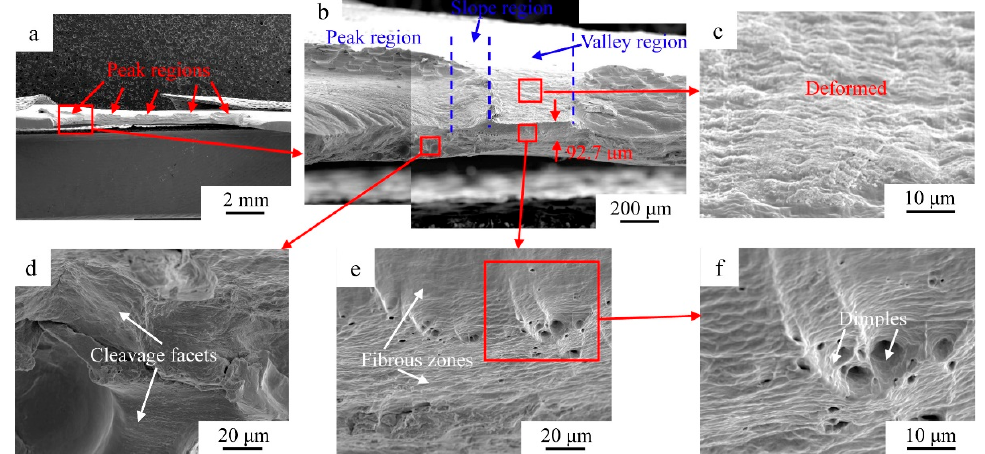
Figure 15. SEM images of the fracture surface of a joint processed with alcohol at 0.55 MPa welding pressure. ( b ) the enlarged drawing indicated in ( a ); ( c – e ) the enlarged drawing indicated in ( b ); ( f ) the enlarged drawing indicated in ( e ).